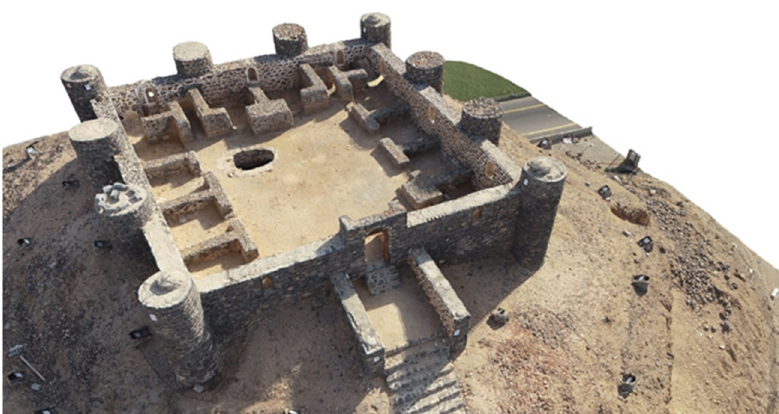
Figure 18. Enhanced 3D model of the Asfan Castle using the UAV and TLS data fusion.